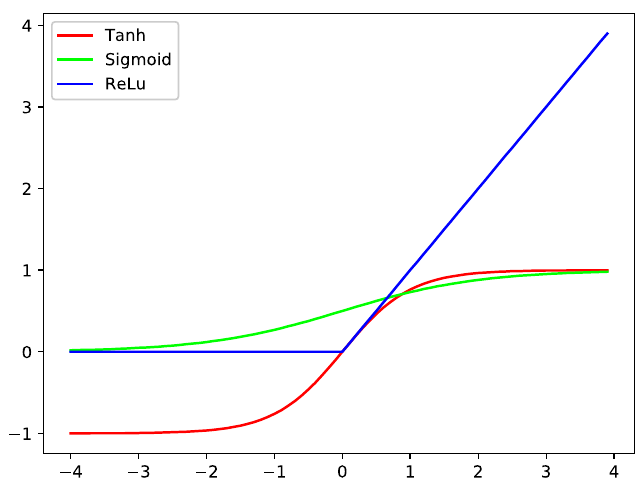
Figure 4. The curves of activation functions.